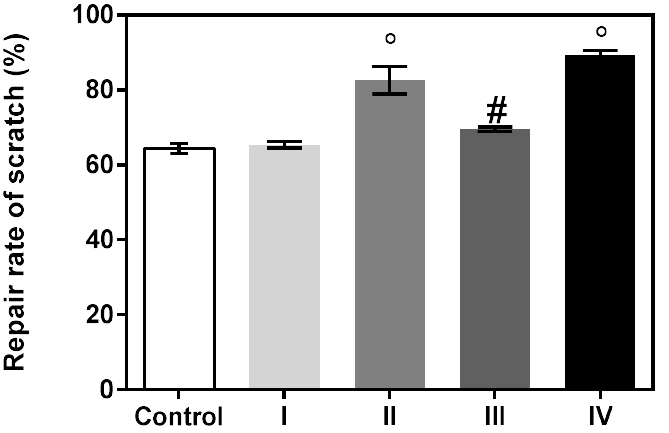
Figure 5. Repair rate of scratch (%) by cellular migration of human keratinocytes (HaCaT, ECACC) assessed by means of ImageJ 1.51 software. Data represent the mean ± SD. (# p < 0.001; ◦ p < 0.0001) compared to control.